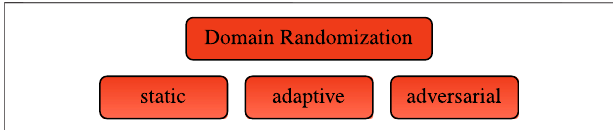
FIGURE 3 | Topological overview of domain randomization